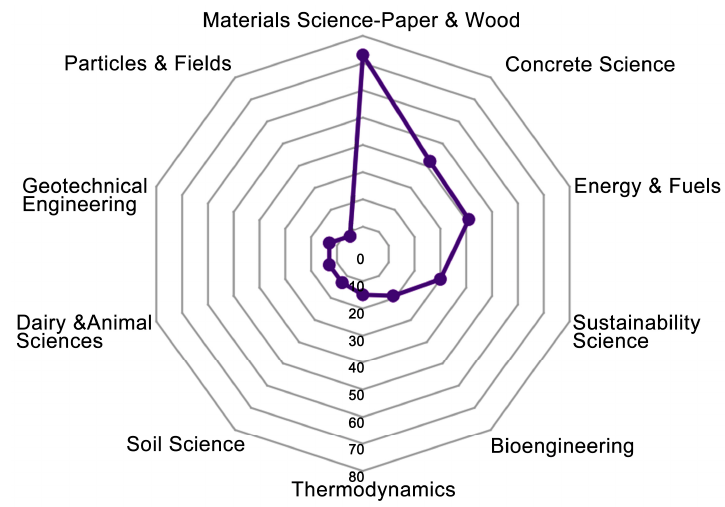
Figure 5. Statistical graph of the top 10 disciplines in terms of the number of published papers.